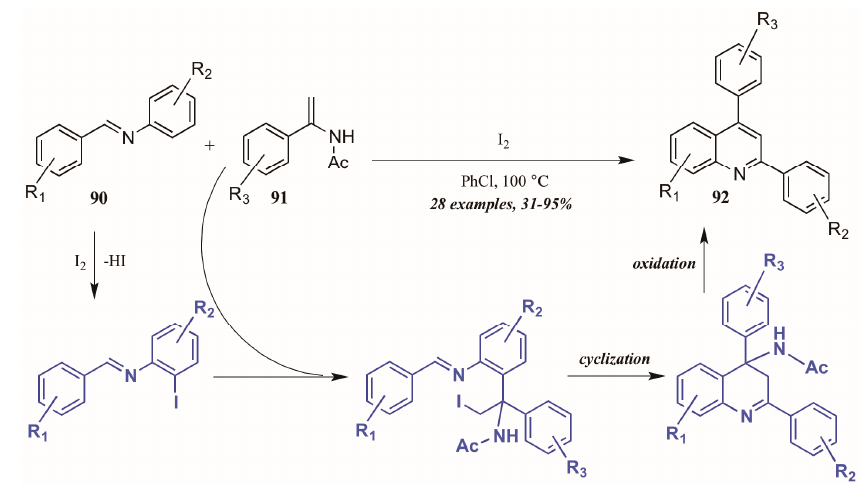
Figure 39. Iodine-catalyzed synthesis of diarylquinolines from enamides and imines.